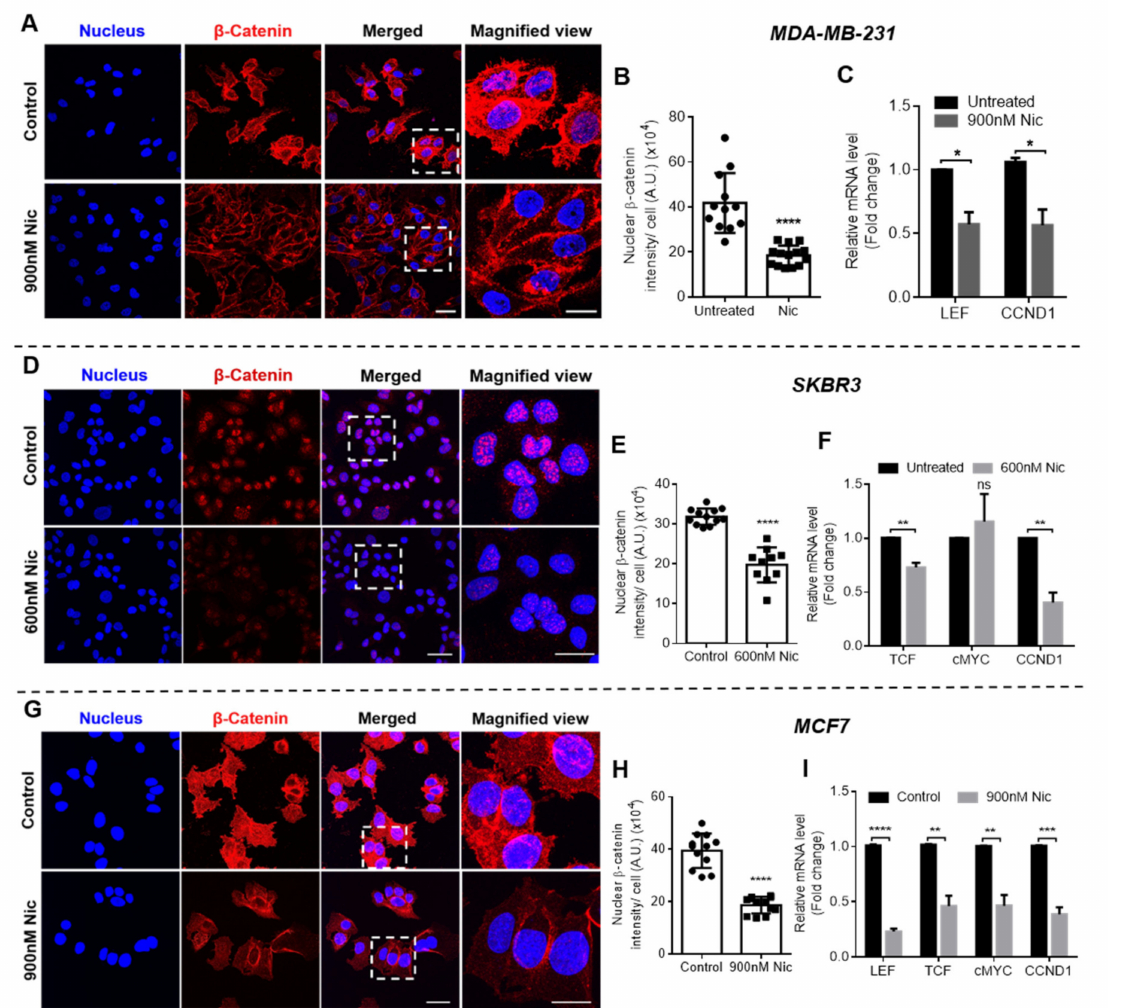
Figure 3. Wnt signaling analysis in breast cancer cells after 24 h treatment of Nic at indicated doses. Representative images of β -catenin immunostaining after 24 h treatment of Nic at selected doses in ( A ) MDA-MB-231, ( D ) SKBR3, and ( G ) MCF7 cells; scale bar—40 µ m; magnified view—20 µ m. Quantification of nuclear β -catenin from immunofluorescent images using MATLAB software in ( B ) MDA-MB-231, ( E ) SKBR3, and ( H ) MCF7 cells. Data represent mean values ± SD (n = 10–15 images). Gene expression analysis of Wnt/ β -catenin signaling markers LEF, TCF, CCND1, and cMYC after 24 h treatment of Nic at indicated doses in ( C ) MDA-MB-231, ( F ) SKBR3, and ( I ) MCF7 cells. Normalized with respect to GAPDH expression. * ( p < 0.05); ** ( p < 0.01), *** ( p < 0.001) and **** ( p < 0.0001) indicate statistically significant difference with respect to untreated group; ns indicates no significant difference ( n =